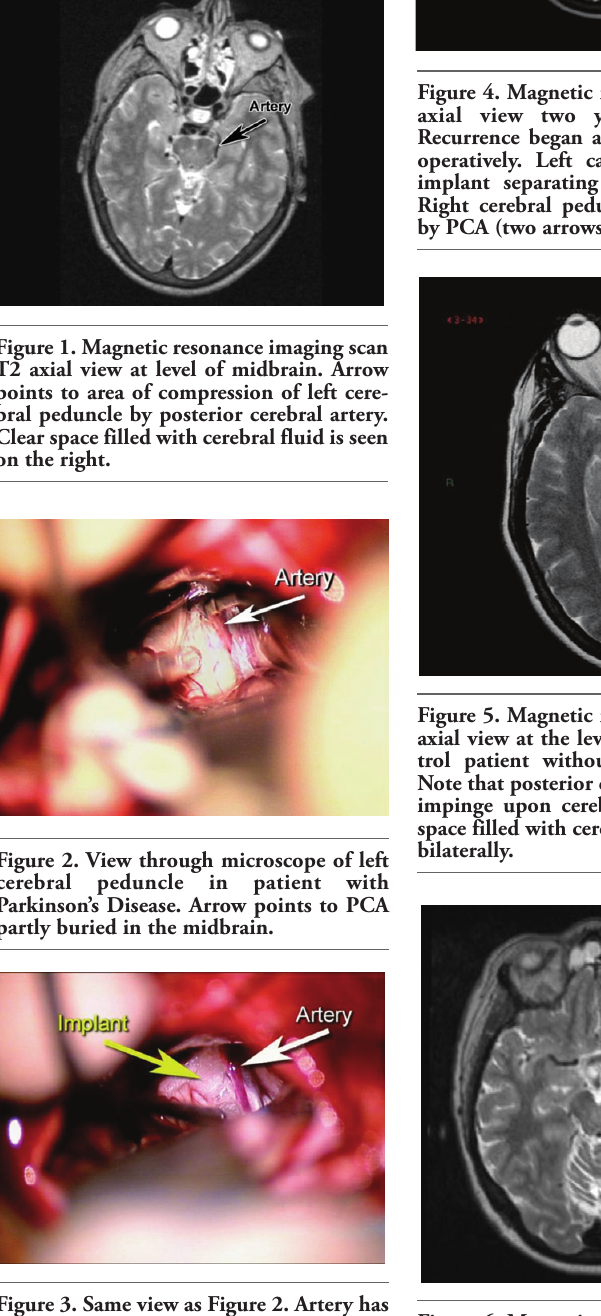
Figure 6. Magnetic resonance imaging T2 Axial view. Bilateral compression in patients with Parkinson